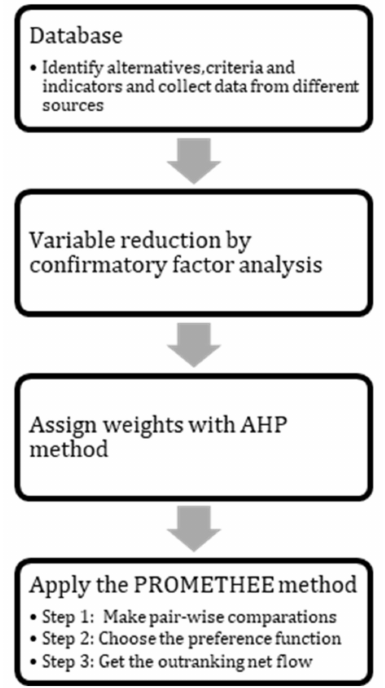
Figure 1. Flow of